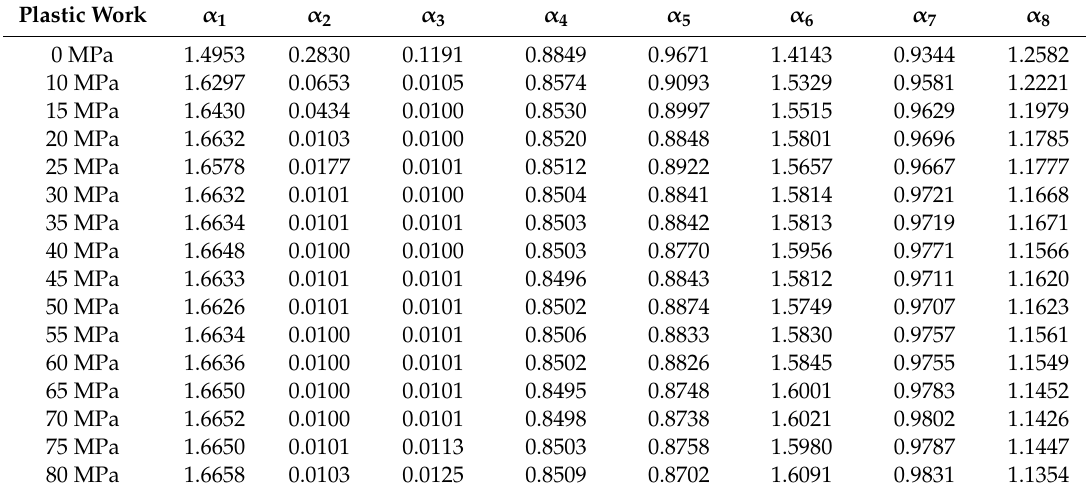
Table 4. Calibrated parameters for the yield function of the Q&P 980 steel ( m = 6).